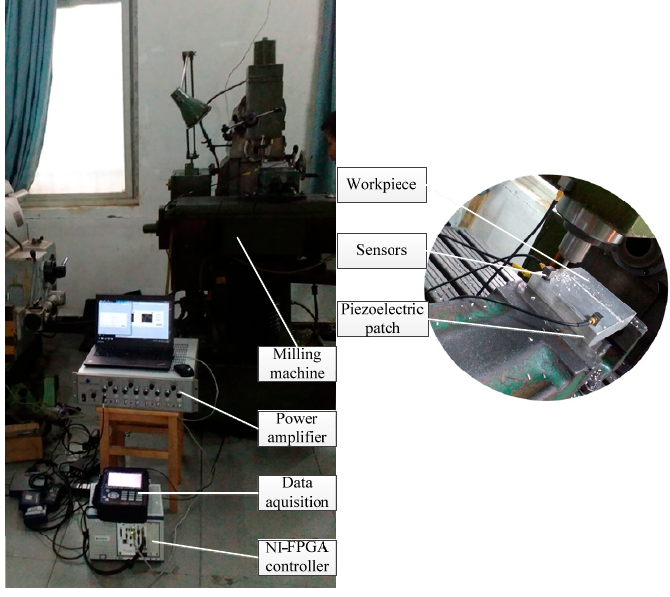
Figure 8. Set-up of the milling process experimental system.